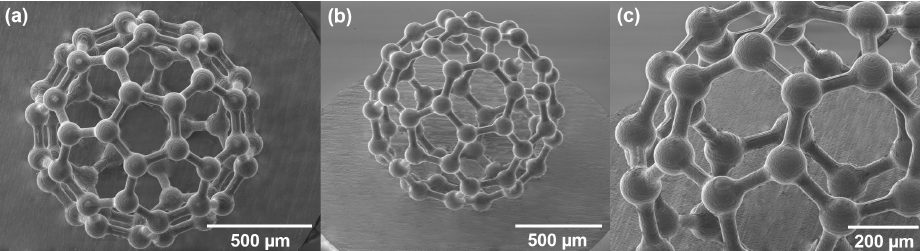
Figure 7. Model of fullerene molecule made out of glass. ( a ) top view of the fullerene structure, ( b ) isometric view to the whole structure, and ( c ) closed look to the same structure. This structure represents the possibility of a high aspect ratio, high surface quality, and high porosity structure which is similar to